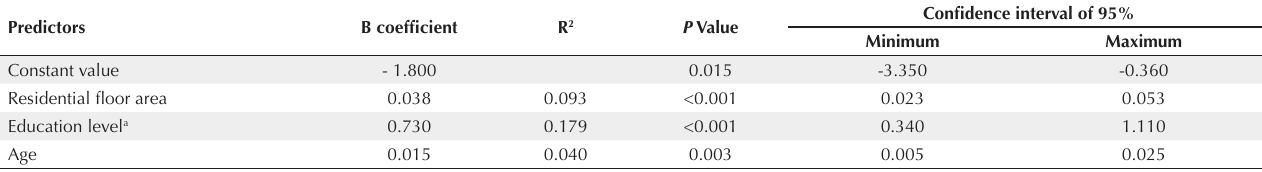
Table 4. Regression Analysis of Predictors Based on the Difference Between BMI Values of Pre- and Post-interventions Predictors B